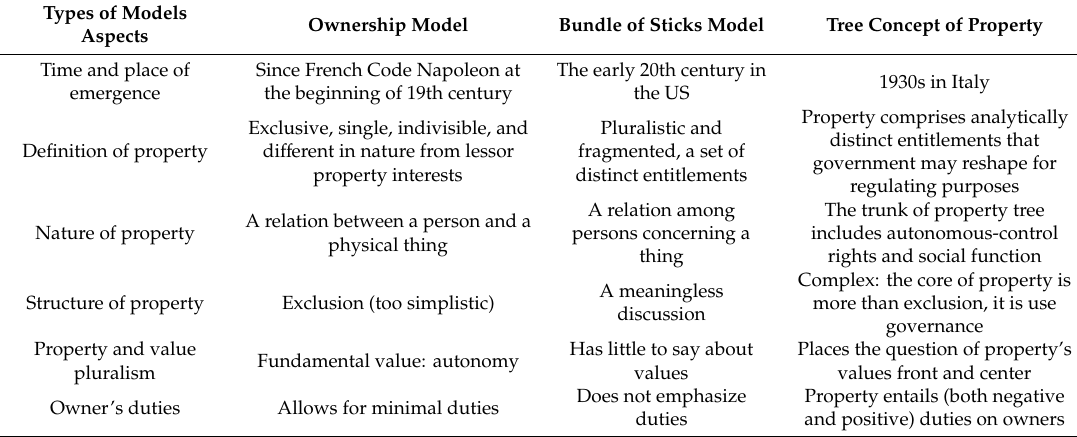
Table 1. Comparison between the tree concept, the ownership model, and the bundle of sticks model of